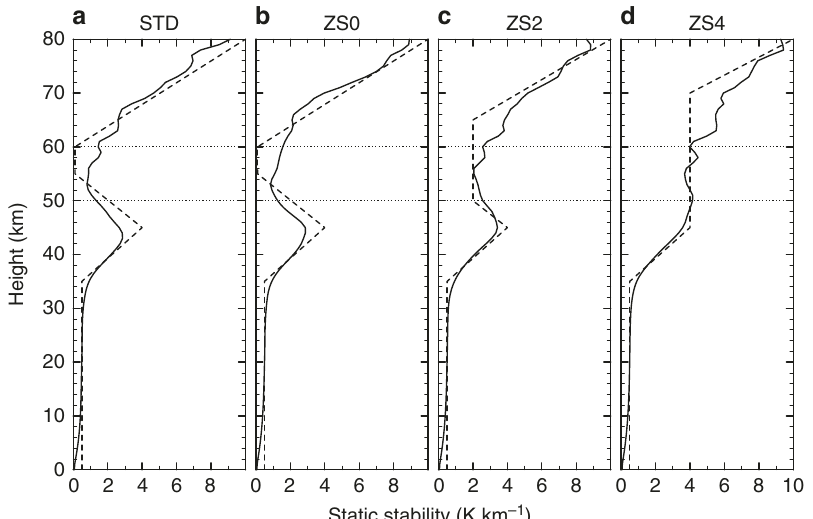
Fig. 3 Vertical pro fi les of the static stability ( Γ − Γ d ). The dashed line shows the static stability of the basic temperature pro fi le for Newtonian cooling and solid line shows that of globally averaged simulated atmosphere in each run of a STD, b ZS0, c ZS2, and d ZS4. Horizontal dotted lines show 50 and 60 km